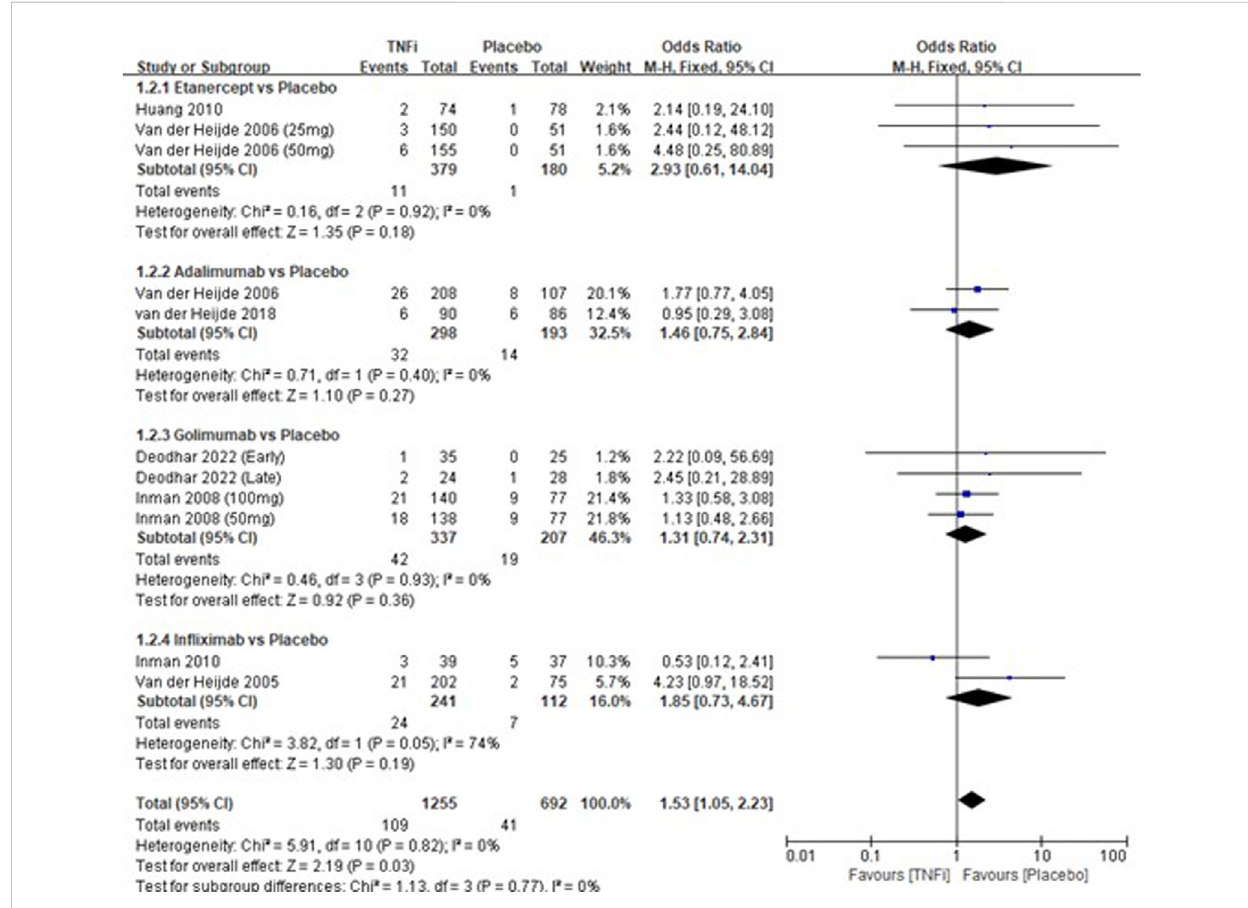
FIGURE 3 Pooled estimate of the incidence of nasopharyngitis between TNFi and placebo groups in patients with ankylosing spondylitis. The odds ratio > 1.0indicatesthat theincidence ofnasopharyngitis is higher intheTNFi groupthan that intheplacebogroup. The subheading “ Events ” refersto the number of incidences of nasopharyngitis. “ Total ” refers to the total number of individuals. CI, con fi dence interval; df, degrees of freedom; M-H, Mantel – Haenszel method of